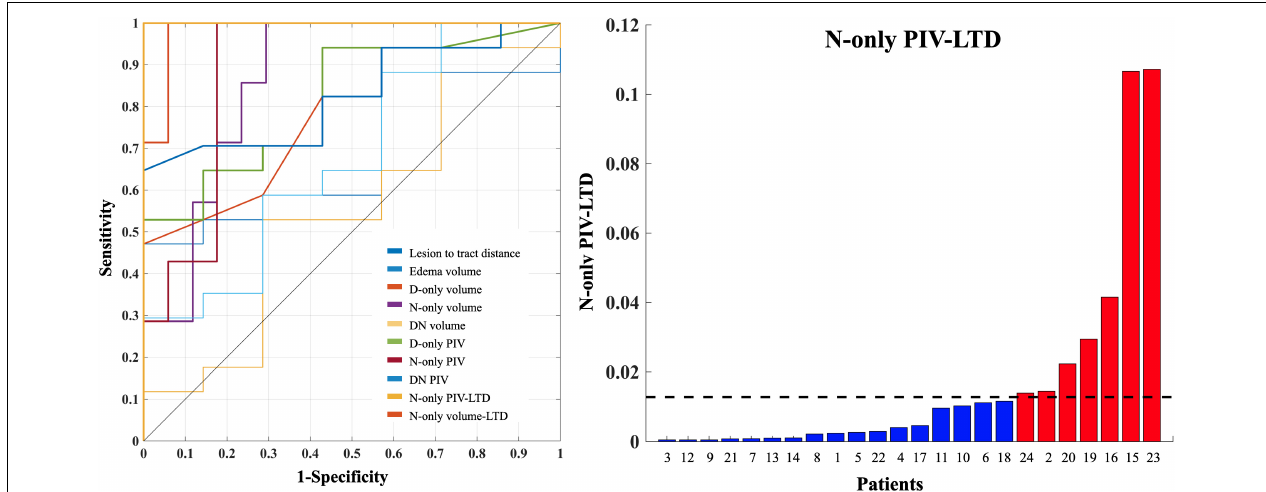
FIGURE 8 | The PIV-LTD of N-only condition and ROC diagnostic performance of motor functions. The PIV of N-only condition weighted by LTD had the best diagnostic performance for determining the presence of motor function decline (left, gold line). An optimal threshold of PIV-LTD of N-only condition > 0.0128 has yielded a sensitivity, specificity, and AUC of 100%, 100%, and 1 for differentiating patients with motor function decline (right). The red and blue color bars indicate patients with and without motor function decline. The black dash line indicates the optimal threshold, determined by using the Youden index. PIV, percentage of involved volume; LTD, lesion-to-tract distance; ROC, receiver operating characteristic; AUC, area under the receiver operating characteristic curve. TABLE 2 | The threshold value and diagnostic performance in motor function decline. Sensitivity Specificity AUC Standard